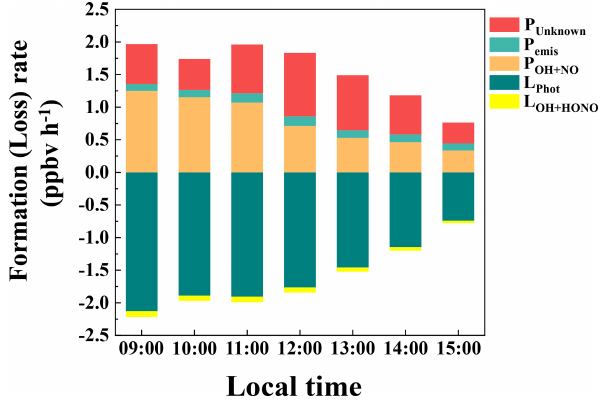
Figure 6. Items in the HONO budget (Eq. 14) for Guangzhou dur- ing the observation